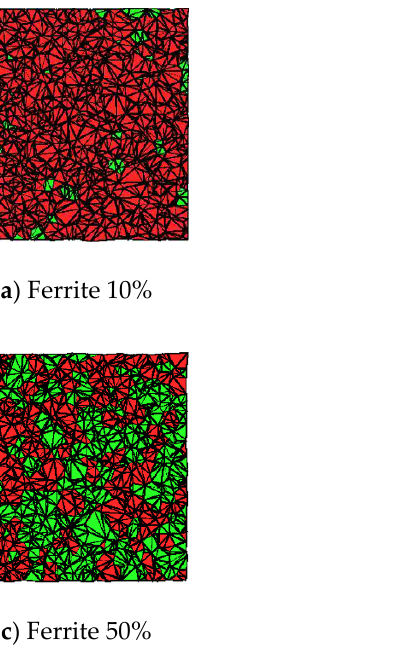
Figure 4. The grain structure of PZT matrix ferroelectric composites with different volume ratios after subdivision. (red grains are PZT, and green grains are ferrite).